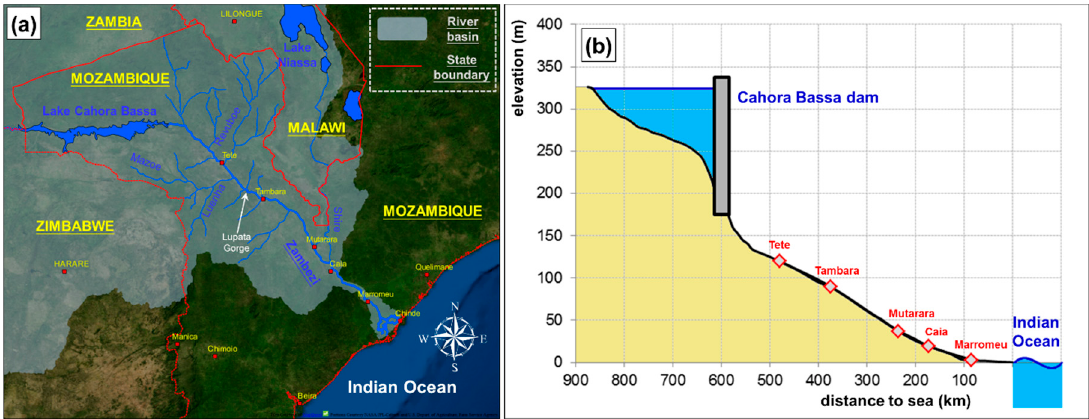
Figure 2. ( a ) Map of the lower Zambezi and main tributaries. ( b ) Longitudinal profile of the main stem of the lower Zambezi; data from [14].